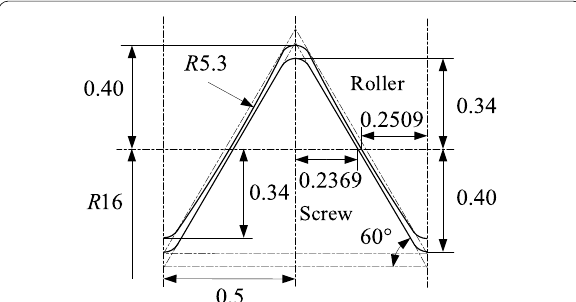
Figure 12 Cross-sectional view of the screw-roller engagement